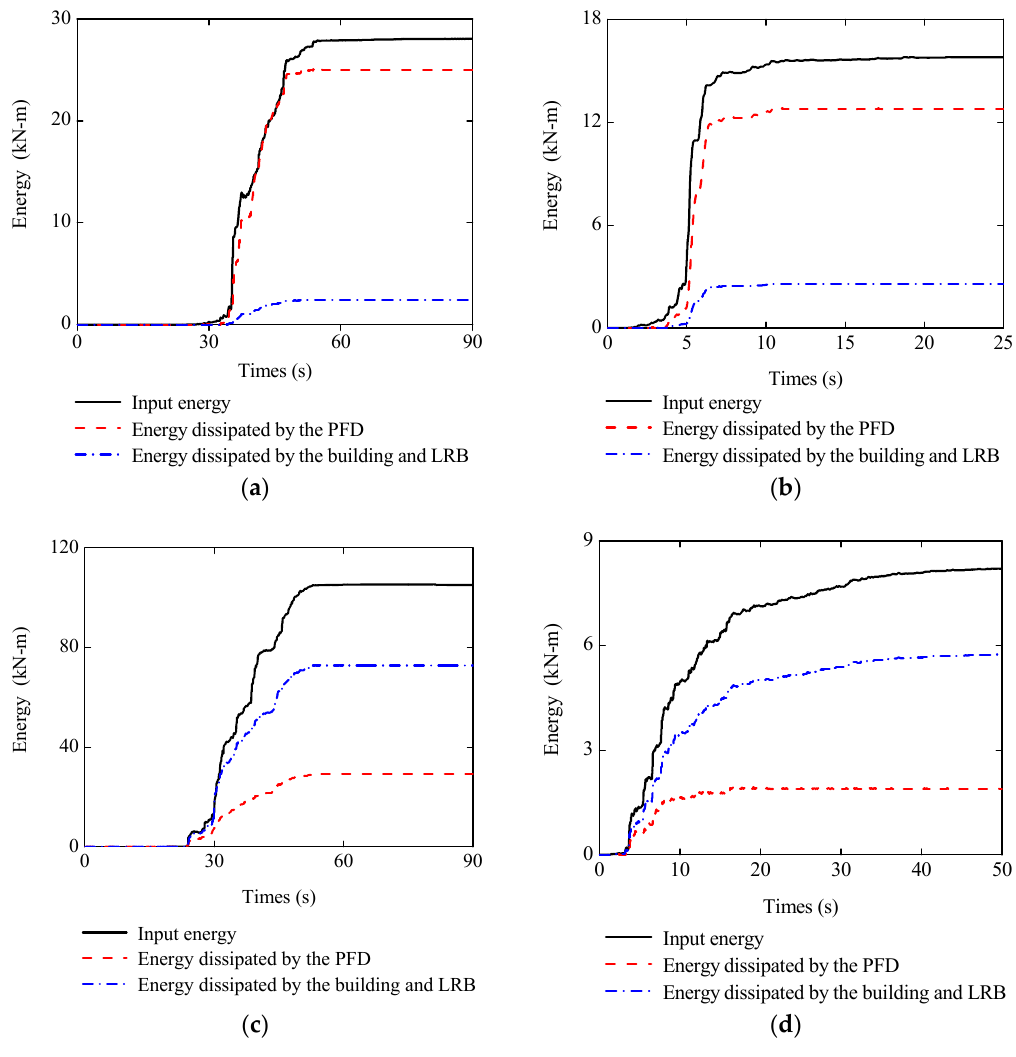
Figure 14. Energy time histories for a base ‐ isolated structure controlled by SHFLC subjected to four types of earthquakes: ( a ) TCU068 ‐ NS record of Chi ‐ Chi earthquake; ( b ) WPI ‐ 316 record of Northridge earthquake; ( c ) TCU071 ‐ EW record of Chi ‐ Chi earthquake; and ( d ) No.095 ‐ S69E record of Taft earthquake.